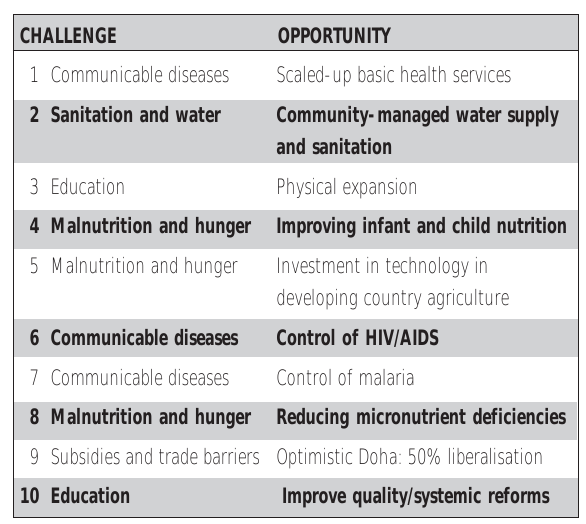
Fig. 2. Outcome of ranking exercise during the Copenhagen Consensus 2006: a United Nations perspective (for more information see